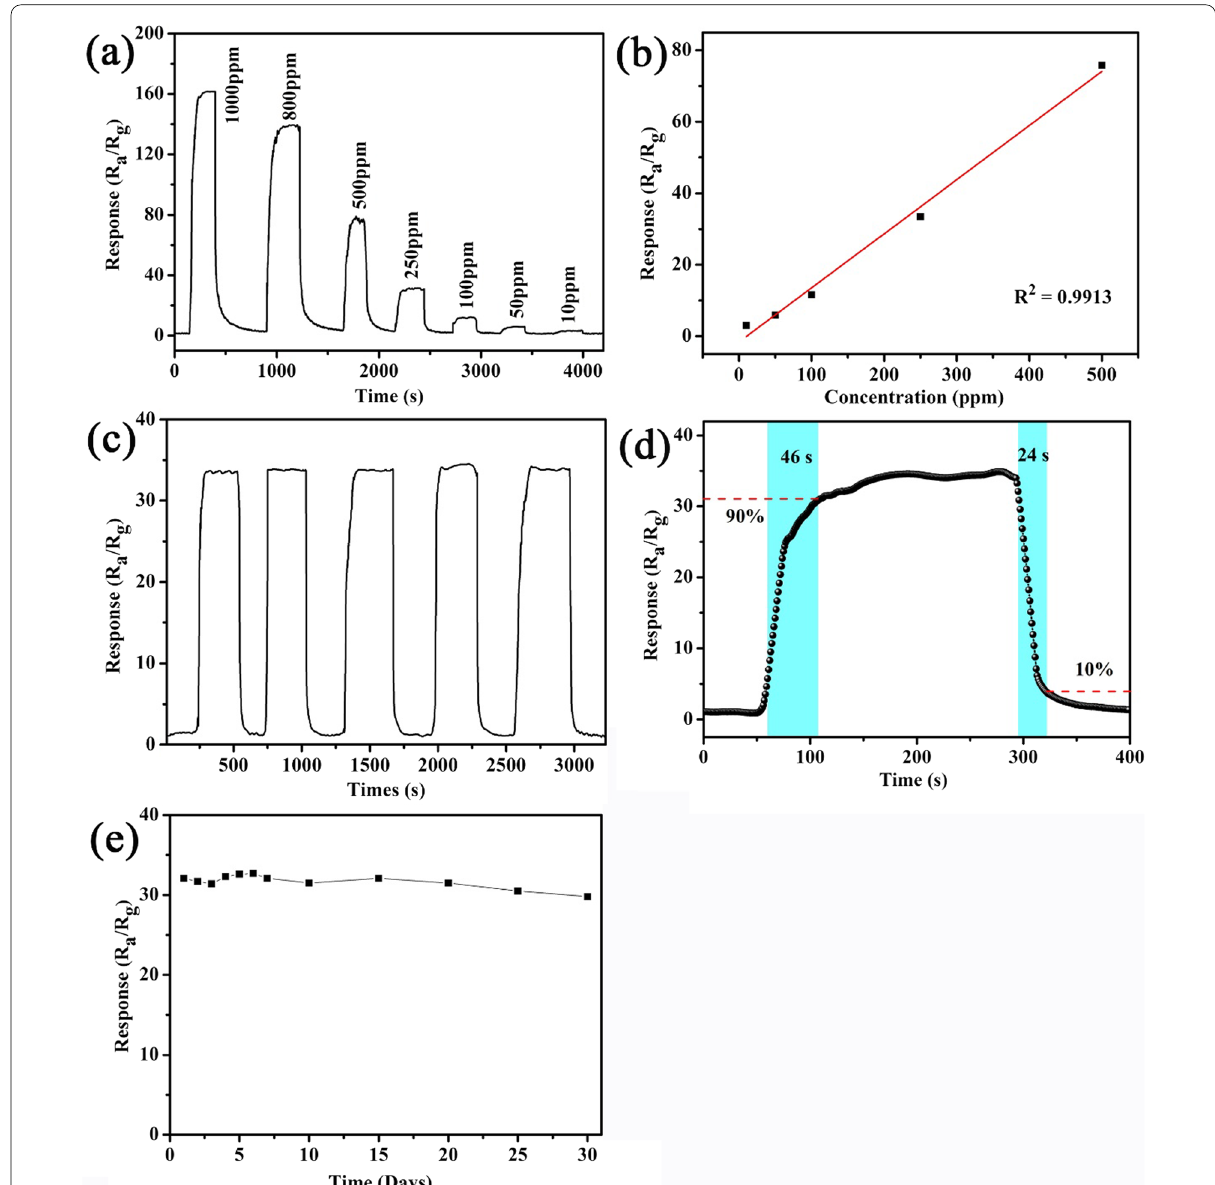
Fig. 7 a TiO 2 FLNMs sensing curves versus different concentration (10–1000 ppm) of acetone at 330 °C; b the linear response of acetone concentration (10–500 ppm); c the reproducibility testing with five cycles; d the response/recovery behaviors of TiO 2 FLNMs; e the